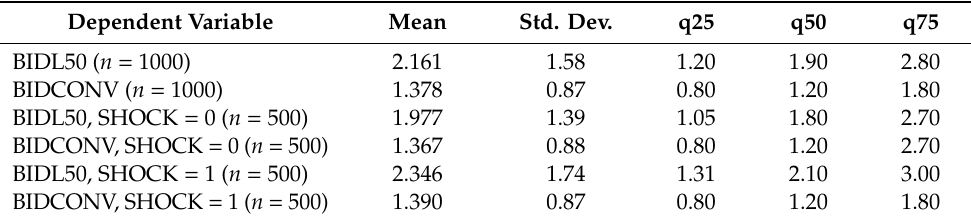
Table 3. Summary statistics of the dependent variables.